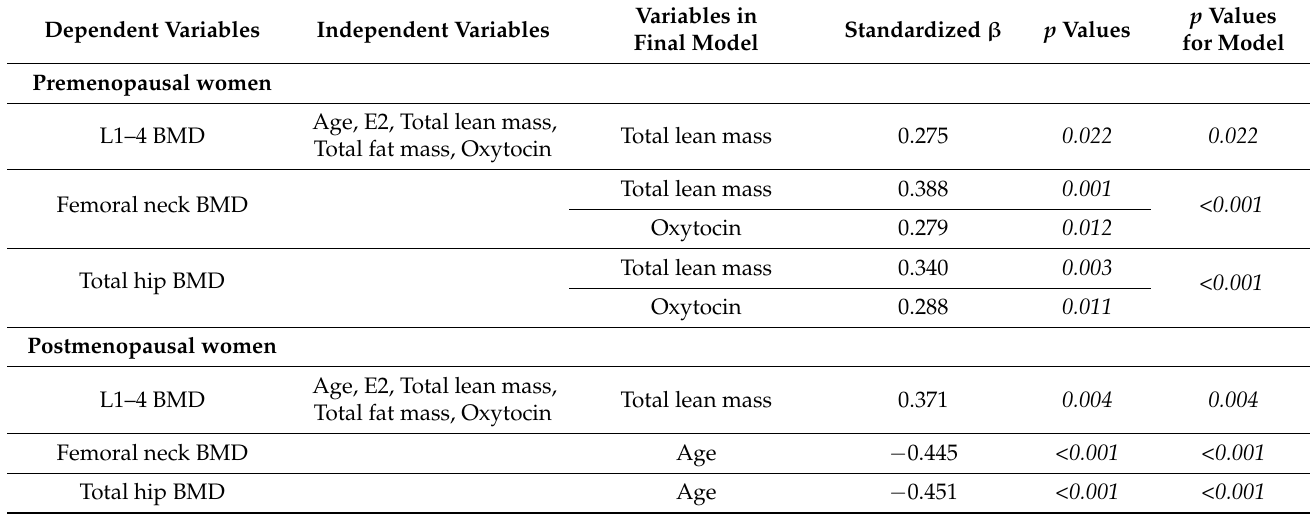
Table 5. Factors determining the variation in BMD in the multivariate stepwise regression